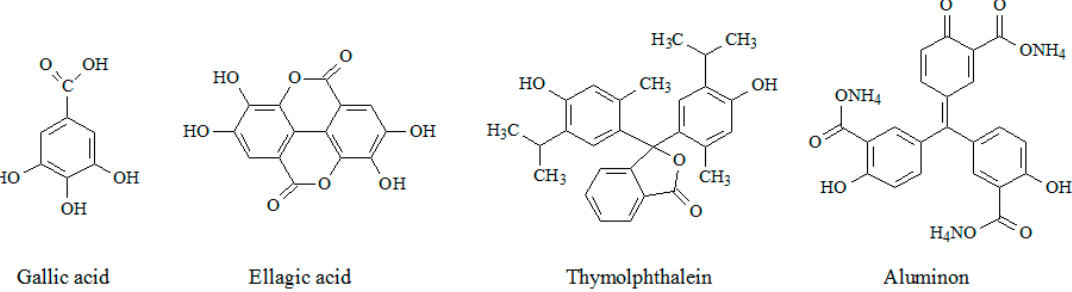
Figure 1. Structure of monomers under investigation.